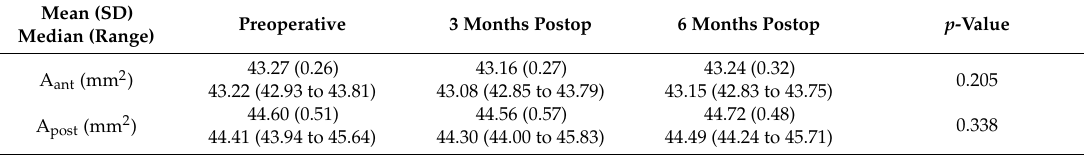
Table 2. Changes in the corneal morphogeometric parameters defined during the follow-up in the analyzed sample. Abbreviations: SD, standard deviation; A ant , anterior corneal surface area; A post , posterior corneal surface area; A tot , total corneal surface area; CV, corneal volume; AAD, anterior apex deviation which is the average distance from the z -axis to the highest point (apex) of the anterior corneal surface; PAD, posterior apex deviation which is the average distance from the z -axis to the highest point (apex) of the posterior corneal surface; AMTPD, anterior minimum thickness point deviation which is the average distance on the xy -plane from the z -axis to the minimum thickness point of the anterior corneal surface; PMTPD, posterior minimum thickness point deviation which is the average distance on the xy -plane from the z -axis to the minimum thickness point of the anterior corneal